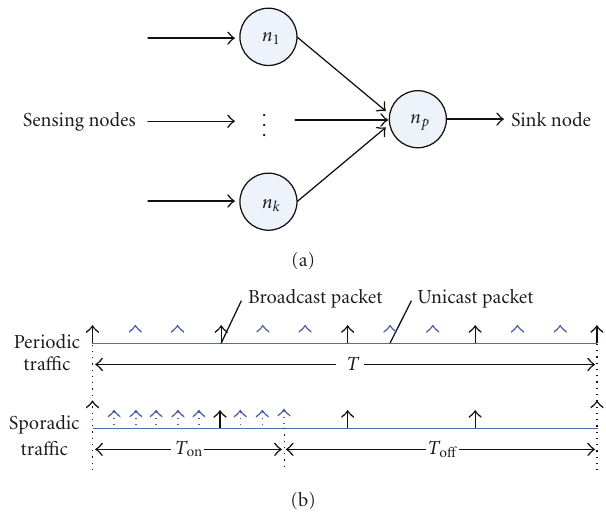
Figure 4: The collection tree based topology and tra ffi c patterns: (a) the parent node, n p can have k children, n 1 – n k in collection tree; (b) periodic tra ffi c and sporadic tra ffi c.